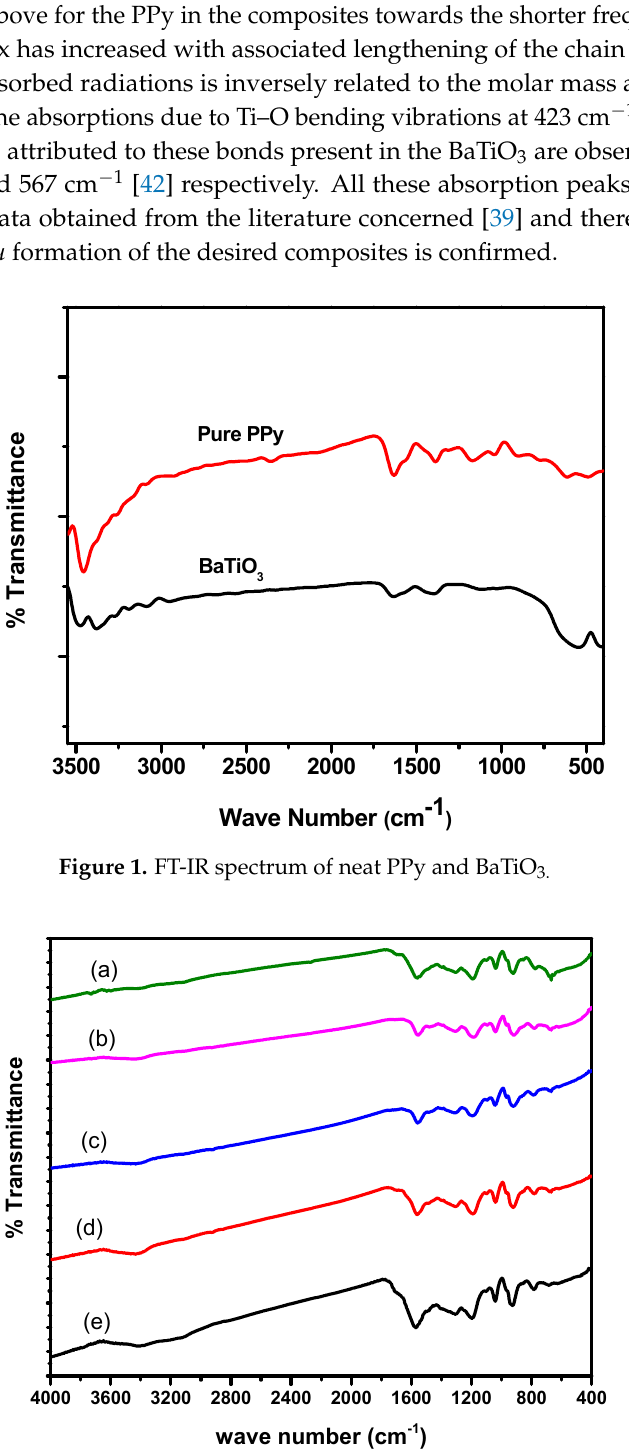
Figure 2. FT-IR spectra of ( a ) PPy/1% BaTiO 3 , ( b ) PPy/2% BaTiO 3 , ( c ) PPy/3% BaTiO 3 , ( d ) PPy/4% BaTiO 3 and ( e ) PPy/5% BaTiO 3 .